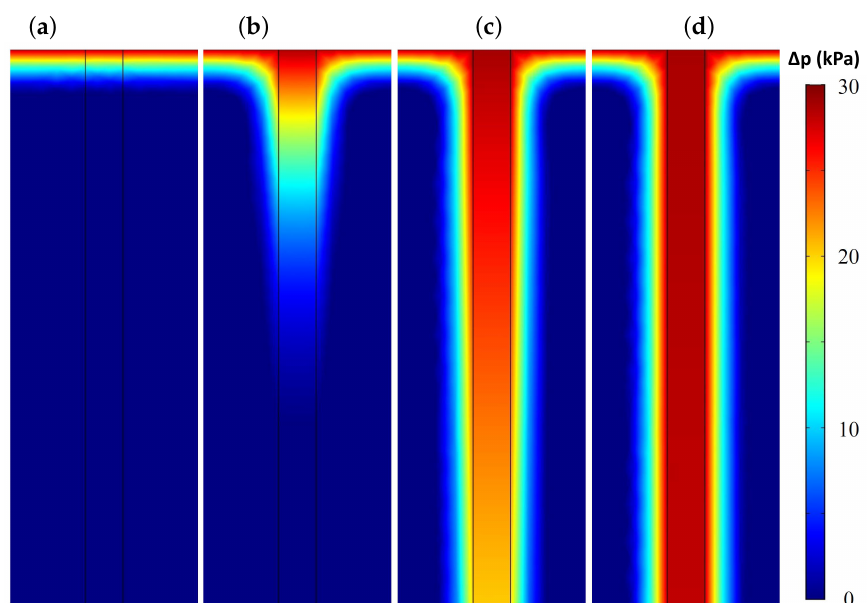
Figure 2. Close-up view (50 m by 150 m) of overpressure near the surface, illustrating the influence of fault permeability on the pore pressure after 63 h (high tide situation), using the Darcy simplification in a 2D model. We represent the increment in the pore pressure for values between 0 and 30 kPa, from warm to cold colors respectively. We have used diverse values of the fault permeability ( k F = 10 − 15 ,10 − 13 ,10 − 11 and 10 − 9 m 2 ) while keeping the host rock permeability constant ( k = 10 − 15 m 2 ). The parameters of the simulations related to this Figure are detailed on Table 1. The compressibility of the solid grains, χ s , is 2.33 · 10 − 10 Pa − 1 . The permeability of the fault is: ( a ) ( k F = 10 − 15 m 2 ),